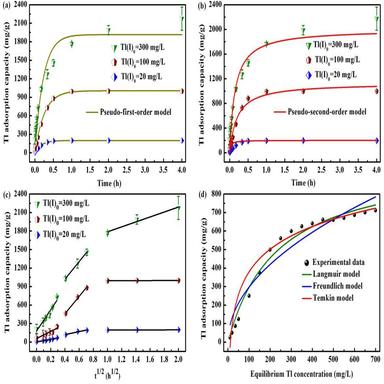
Kinetics for Tl(I) adsorption using nZVIM at different Tl(I)0: (a) pseudo-first order, (b) pseudo-second order, (c) Weber-Morris model; (d) the isotherms for Tl (I) removal using nZVIM (adsorbent dosage = 0.40 g/L, NaClO dosage = 10 mM, solution pH = 10, reaction time = 30 min).